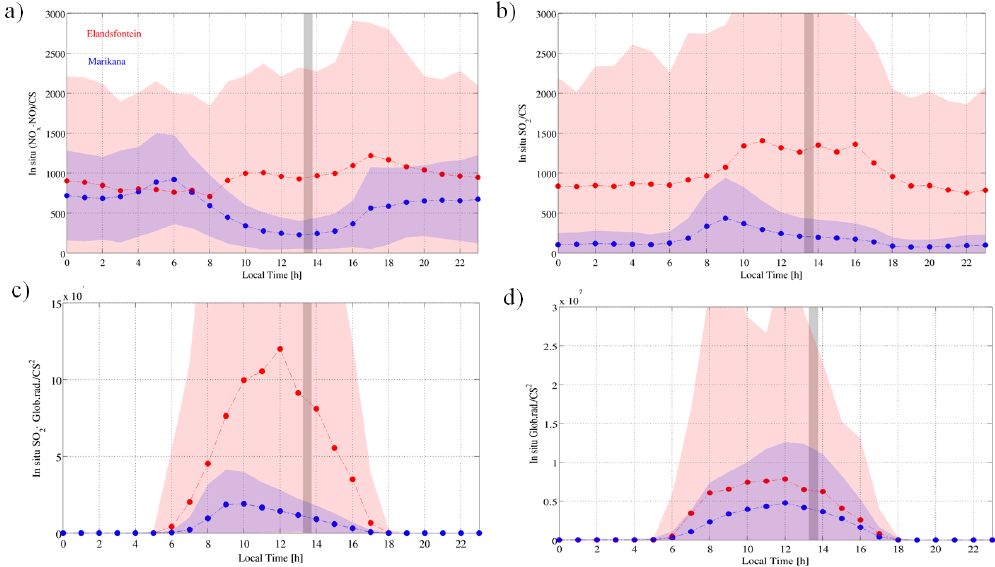
Figure 8. Diurnal variation of the proxies calculated using in situ data at Elandsfontein (red) and at Marikana (blue) stations. The red and blue shaded areas denote the 75th and 25th percentile ranges. The grey column represents the time of the satellite overpass.